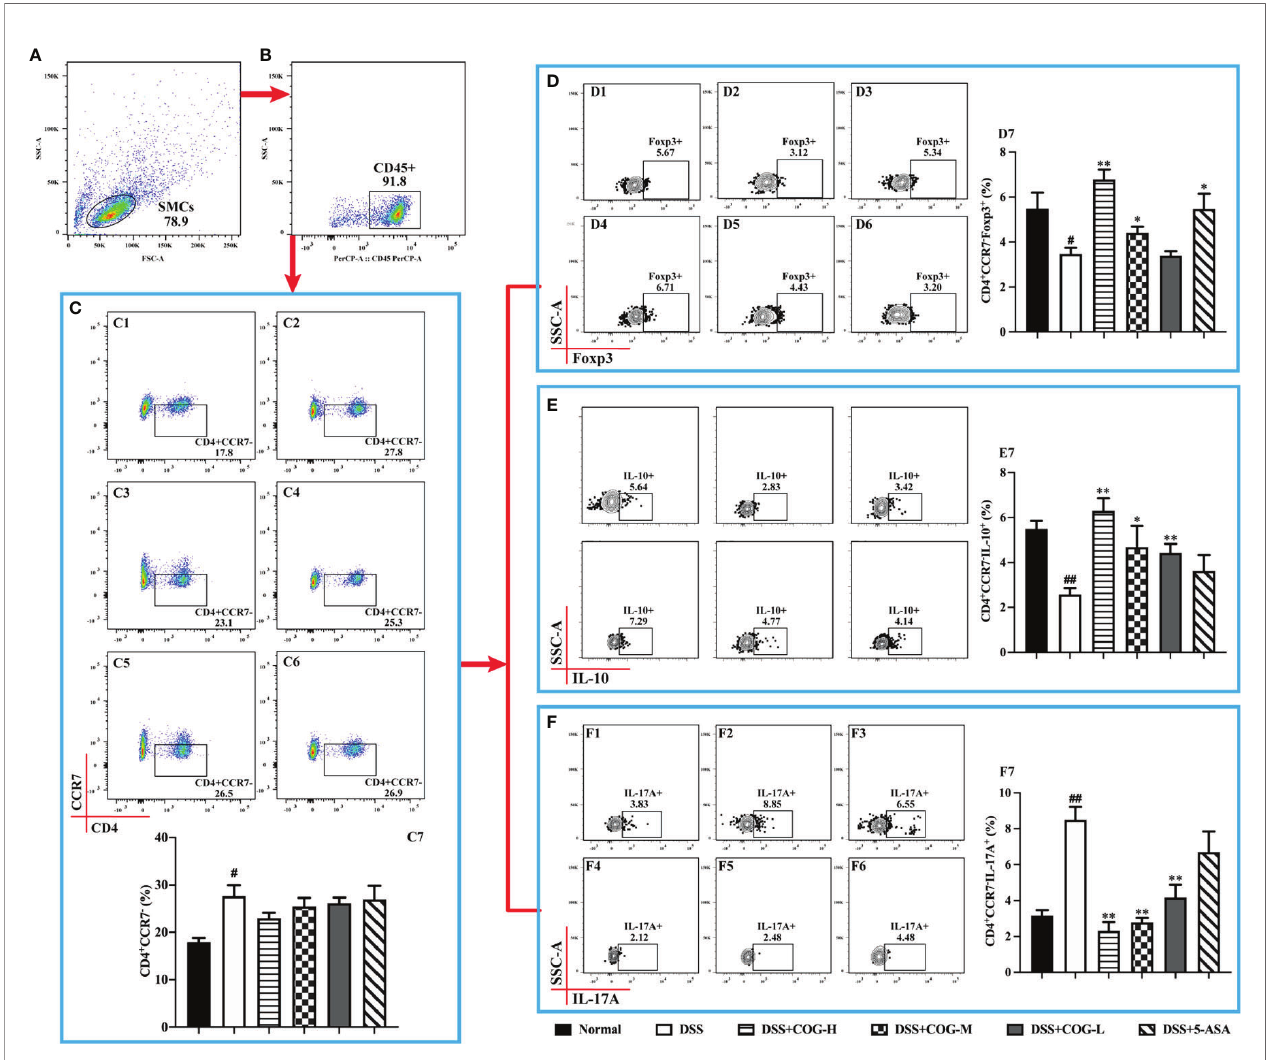
FIGURE 7 | COG regulated CCR7 − CD4 + T cells in mice with colitis. (A) Spleen mononuclear cells (SMCs). (B) CD45 + cells. (C) Flow cytometry analysis of CCR7 − memory T cells: C1 – C6 represent CCR7 − memory T cells in the normal, DSS, DSS+COG-H, DSS+COG-M, DSS+COG-L, and DSS+5-ASA groups, respectively; C7: statistical analysis of CCR7 − memory T-cell frequencies in these six groups. (D) Flow cytometry analysis of Foxp3 + CCR7 − memory T cells: D1 – D6 represent Foxp3 + CCR7 − memory T cells in the normal, DSS, DSS+COG-H, DSS+COG-M, DSS+COG-L, and DSS+5-ASA groups, respectively; D7: statistical analysis of Foxp3 + CCR7 − memory T-cell frequencies in these six groups. (E) Flow cytometry analysis of IL-10 + CCR7 − memory T cells: E1 – E6 represent IL-10 + CCR7 − memory T cells in the normal, DSS, DSS+COG-H, DSS+COG-M, DSS+COG-L, and DSS+5-ASA groups, respectively; E7: statistical analysis of Foxp3 + CCR7 − memory T-cell frequencies in these six groups. (F) Flow cytometry analysis of IL-17A + CCR7 − memory T cells: F1 – F6 represent IL- 17A + CCR7 − memory T cells in the normal, DSS, DSS+COG-H, DSS+COG-M, DSS+COG-L, and DSS+5-ASA groups, respectively; F7: statistical analysis of